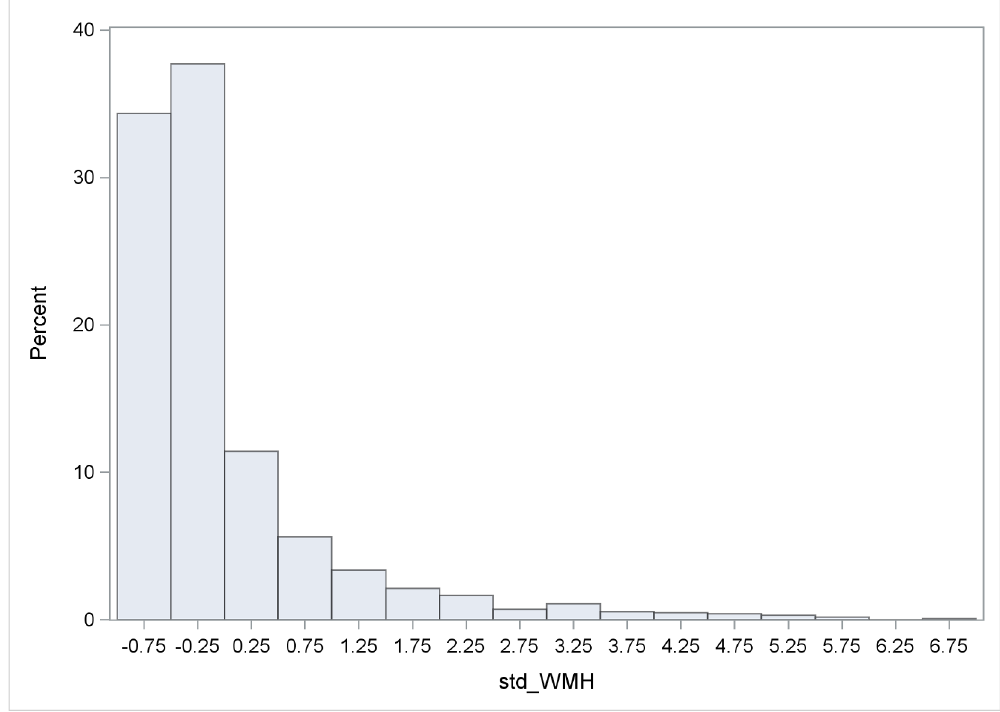
Fig 3. Distribution of WMHVs. WMHV as percentage of TCV. BP, blood pressure; CVD, cardiovascular disease; TCV, total cranial volume; WMHV, white matter hyperintensity